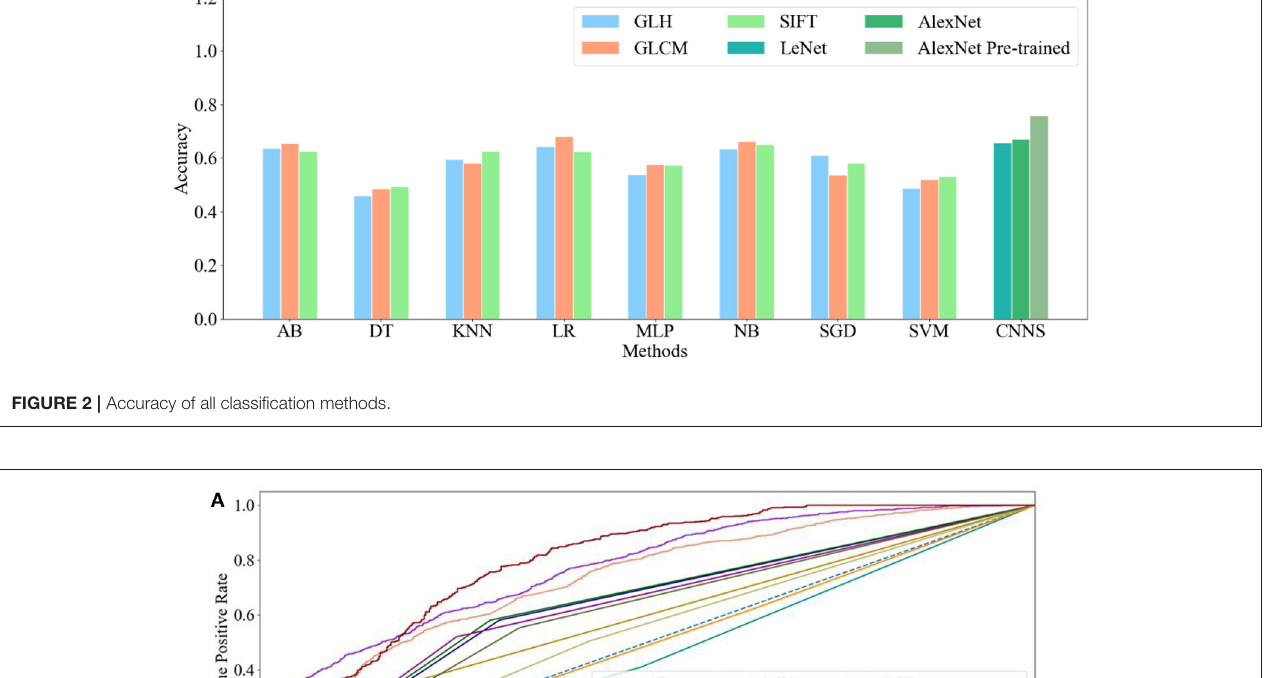
Frontiers in Bioengineering and Biotechnology |